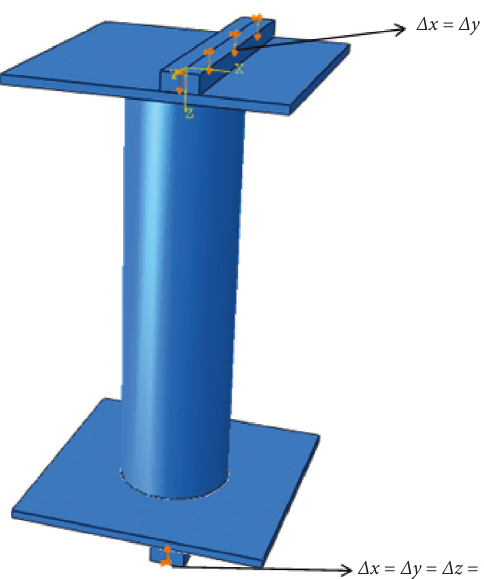
Figure 12: Load and boundary